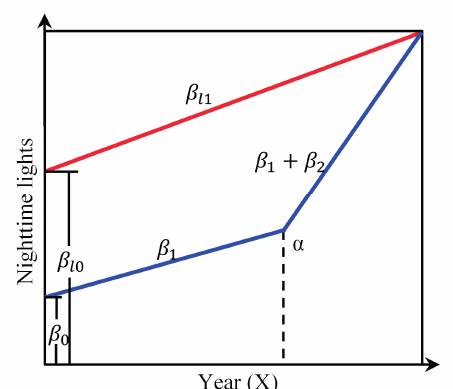
Figure 2. Schematic diagram of models for depict temporal variation of DMSP/OLS nighttime light brightness. Linear model (red lines): β Piecewise linear model (blue lines): α = turning point, β β = difference in slope. 2